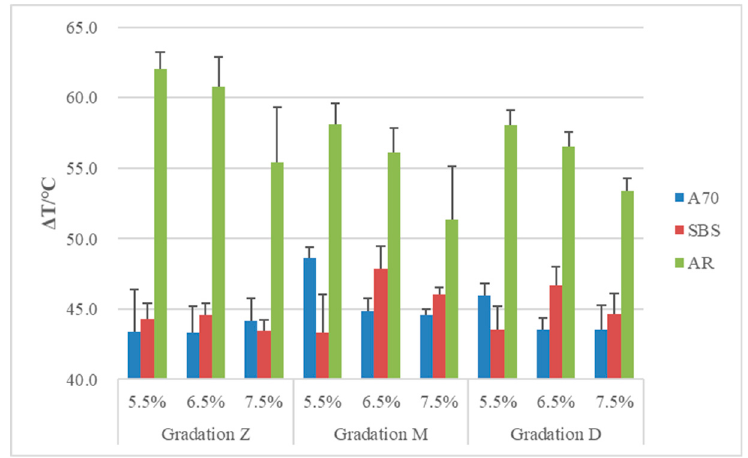
Figure 11. Δ T of asphalt mixtures. Figure 11. ∆ T of asphalt mixtures.